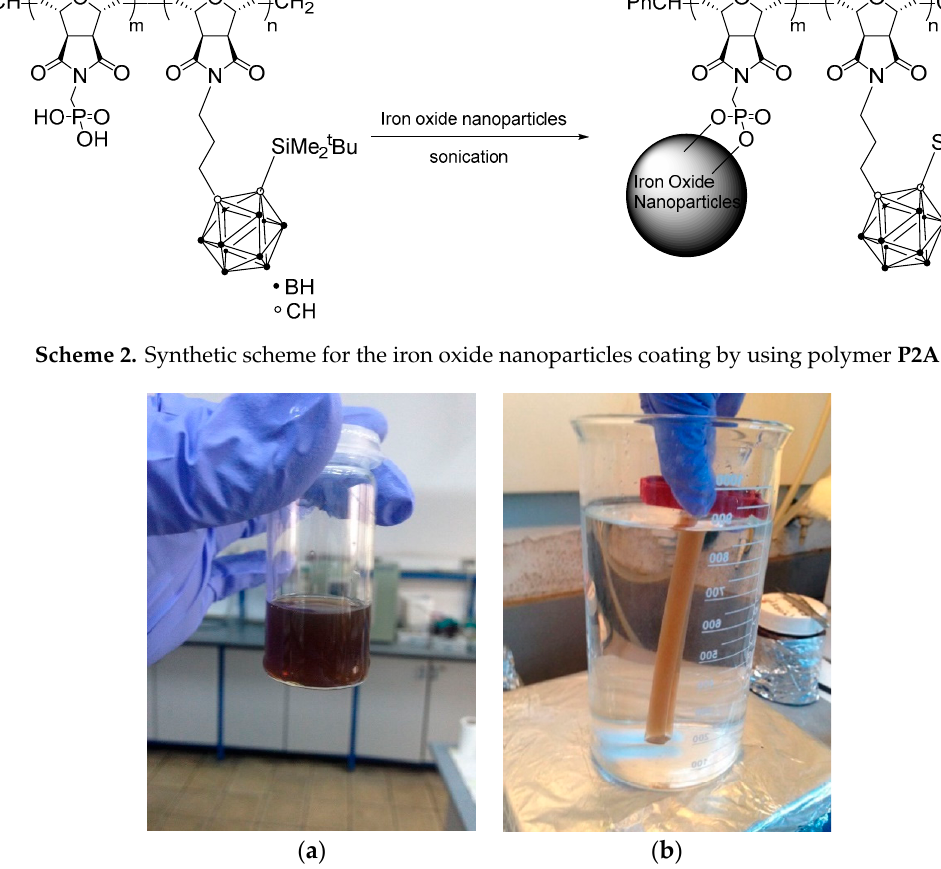
Figure 5. Iron oxide nanoparticles coated with phosphonate-bearing block copolymer P2A . ( a ) P2A-iron oxide nanoparticles in DMSO, before dialysis; ( b ) P2A-iron oxide nanoparticles in water, after dialysis.